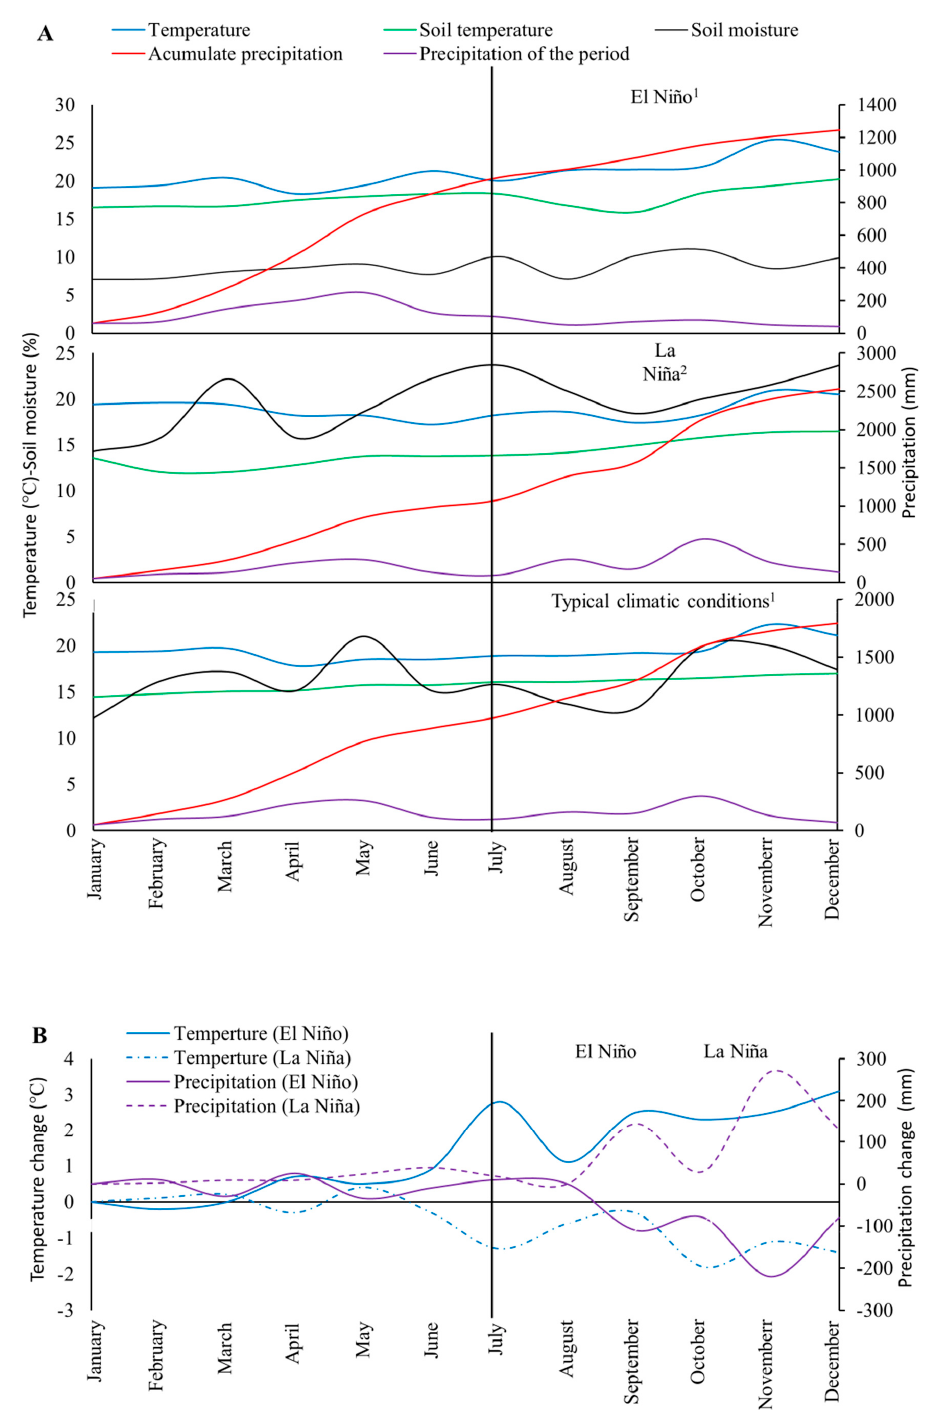
Figure 7. Climatic conditions under ENSO phenomenon (El Niño-La Niña) and typical standard conditions in the regions where experimental plots of avocado crops were located. ( A ) Temporal variation of climatic variables in the lots evaluated. 1 Soil moisture (real value / 5) and 2 Soil moisture (real value / 7); ( B ) Change in climatic variables under ENSO